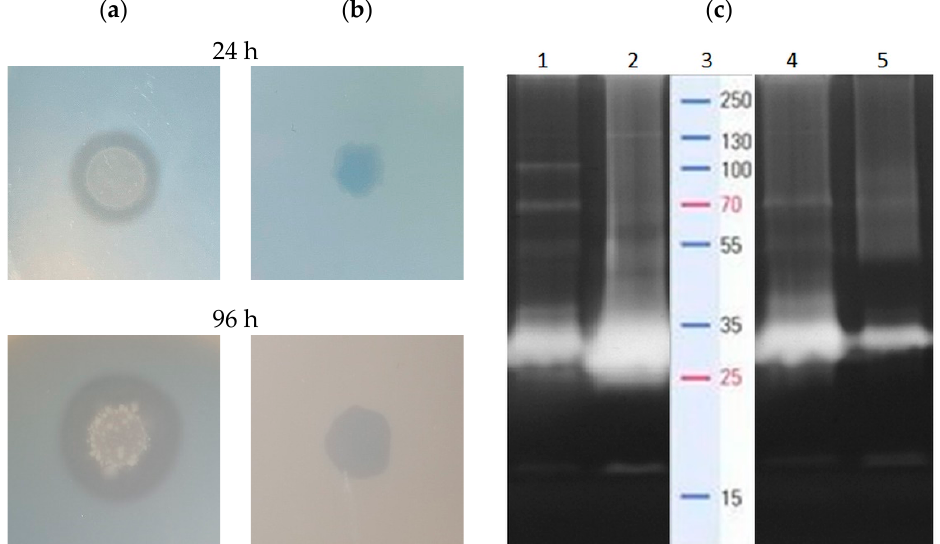
Figure 2. Proteolytic ( a ) and lipolytic ( b ) activity of B. subtilis #309. ( c ) Gelatin zymogram shows clear proteolytic bands of protein cleavage on 10% sodium dodecyl sulfate-polyacrylamide gel elec- trophoresis (SDS-PAGE) in the hours following B. subtilis culture conducted in the rapeseed and sunflower cake medium. Lane 1: rapeseed cake (24 h), lane 2: rapeseed cake (96 h), lane 3: molecular mass marker, lane 4: sunflower cake (24 h), lane 5: sunflower cake (96